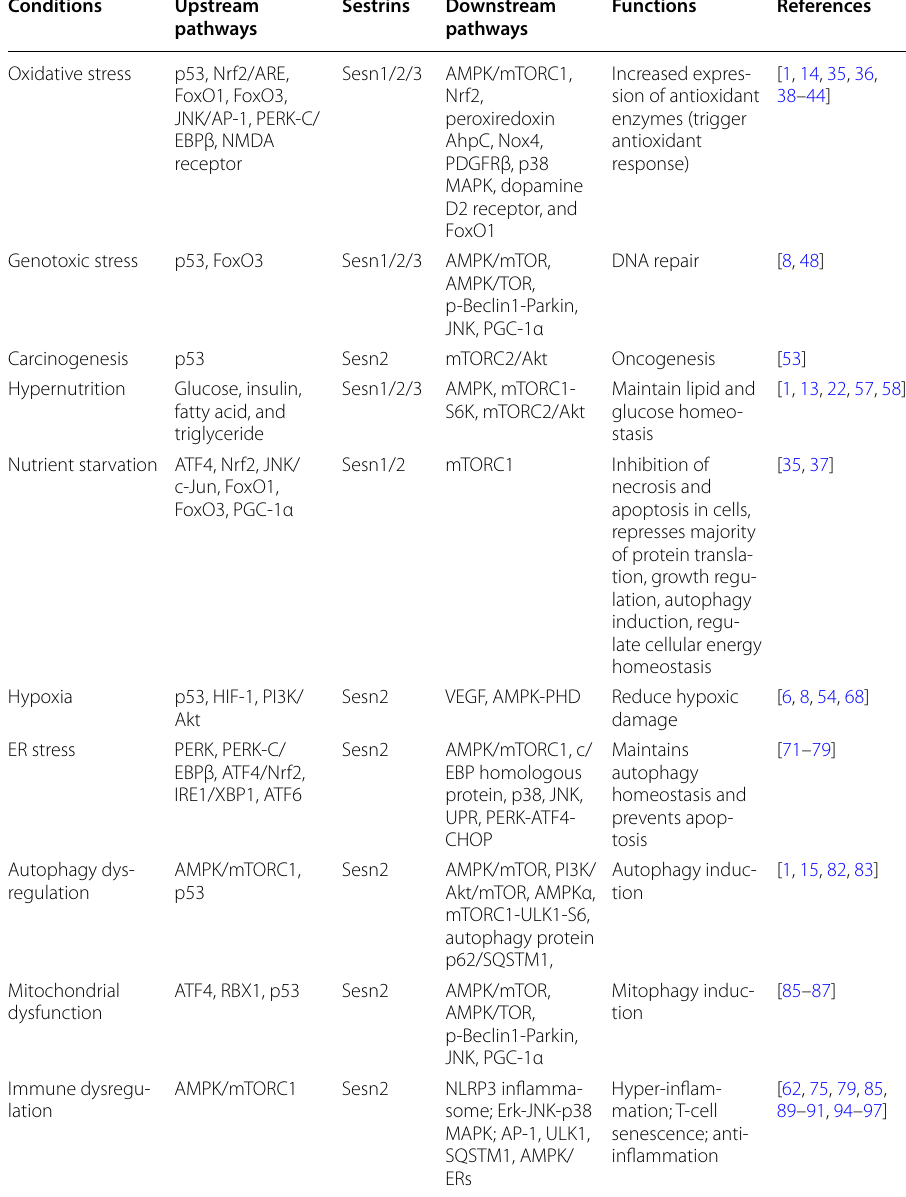
Table 2 Biological functions of sestrins in pathophysiological